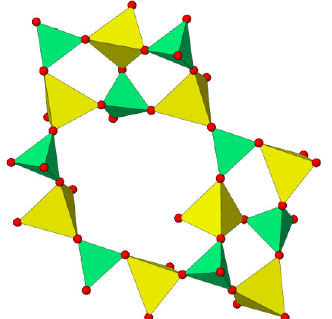
Figure 5. Fragment of a (100) polyhedral sheet in 2 showing 4-ring and 10-ring loops.